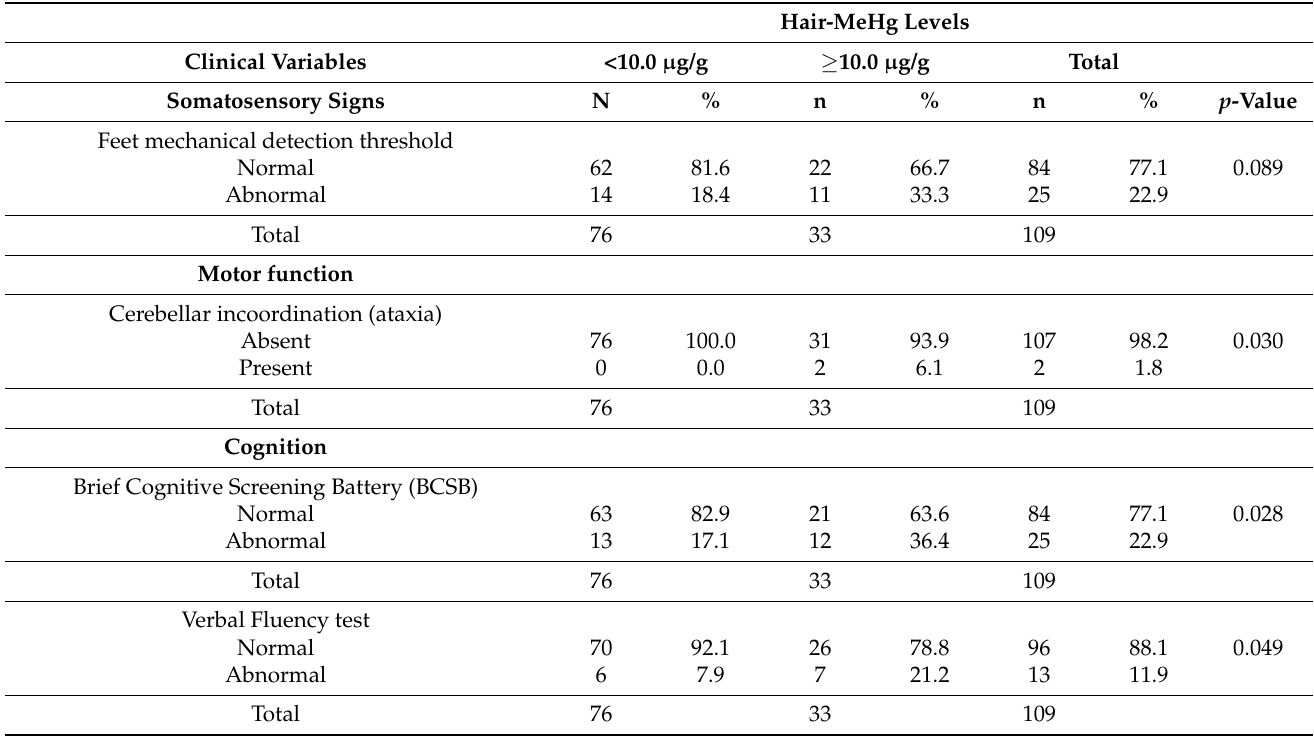
Table 3. Summary of the main results highlighting clinical variables that presented an association ( p -value < 0.10) with hair-MeHg levels ( ≥ 10 µ g/g), Sawr é Muybu Indigenous Land, Par á state, Brazilian Amazon, 2019.